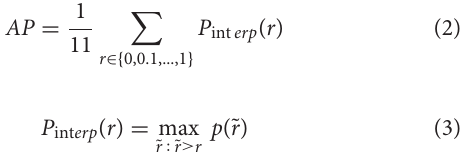
TABLE 1 | Identification of True positive and false positive bounding boxes generated by the primary diagnosis unit.